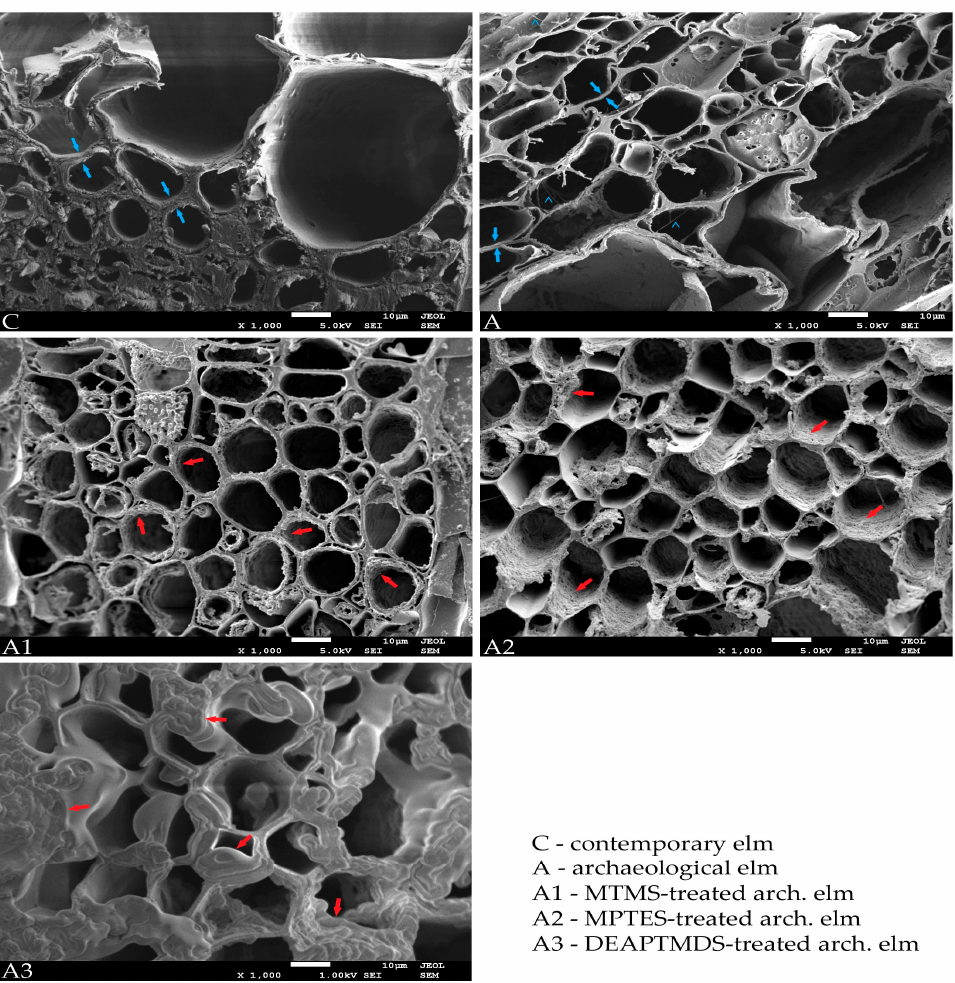
Figure 4. Scanning electron microscope (SEM) images of untreated (C, A) and treated (A1, A2, A3) elm; blue arrows point to the thickness of the cell walls of non-degraded (C) and degraded (A) wood, red arrows indicate organosilicon layers on the cell wall of treated archaeological elm (A1, A2, A3), ˆ indicate fungal